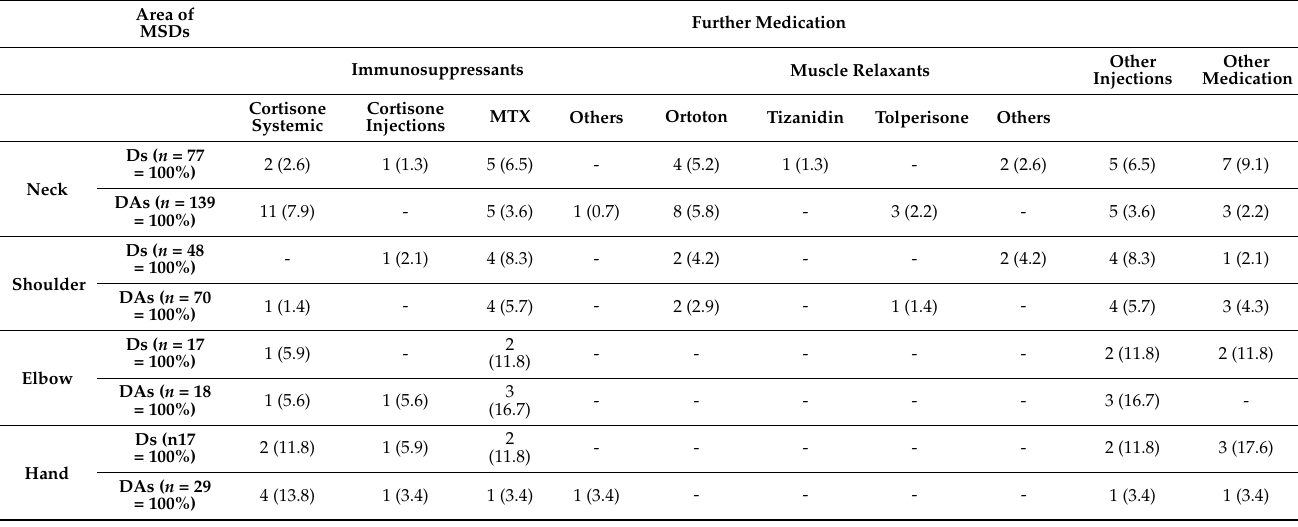
Table 6. Use of co-analgesics in treating MSDs of Ds and DAs, according to body region in n (%). Area of